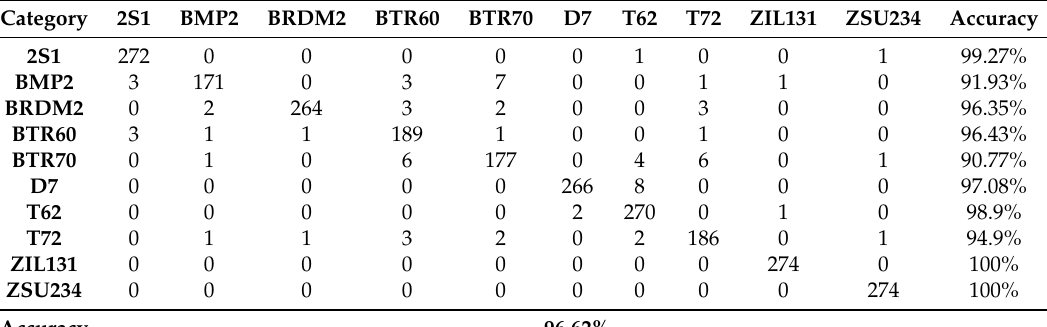
Table 9. Confusion matrix of 10-class recognition result